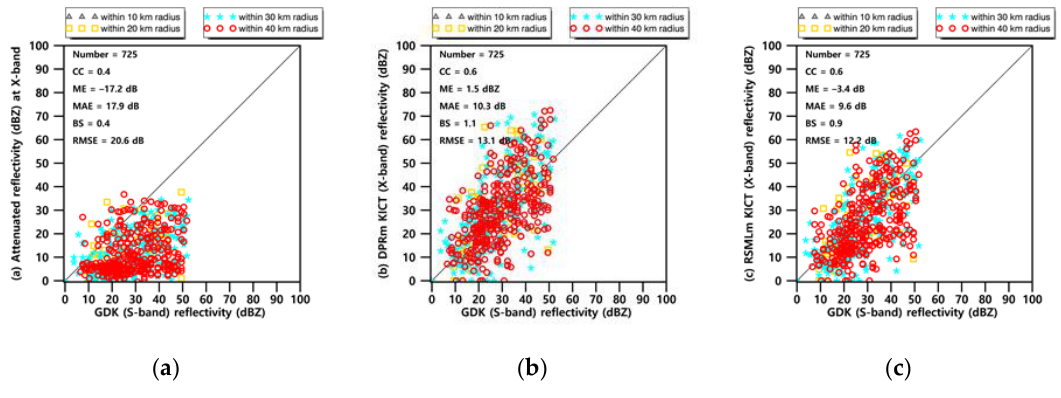
Figure 9. Box-whisker plots of time-varying optimized attenuation correction coefficients, a , with each individual microwave link determined by MMLm during ( a ) the convective rainfall case and ( b ) the stratiform rainfall